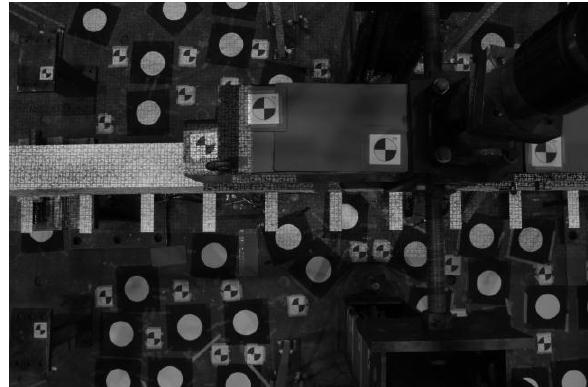
Figure 7. Example of the absence of signalized targets and the presence of a projected random pattern on the surface of the concrete beam during the data collection campaigns for both the static and the dynamic loading cases